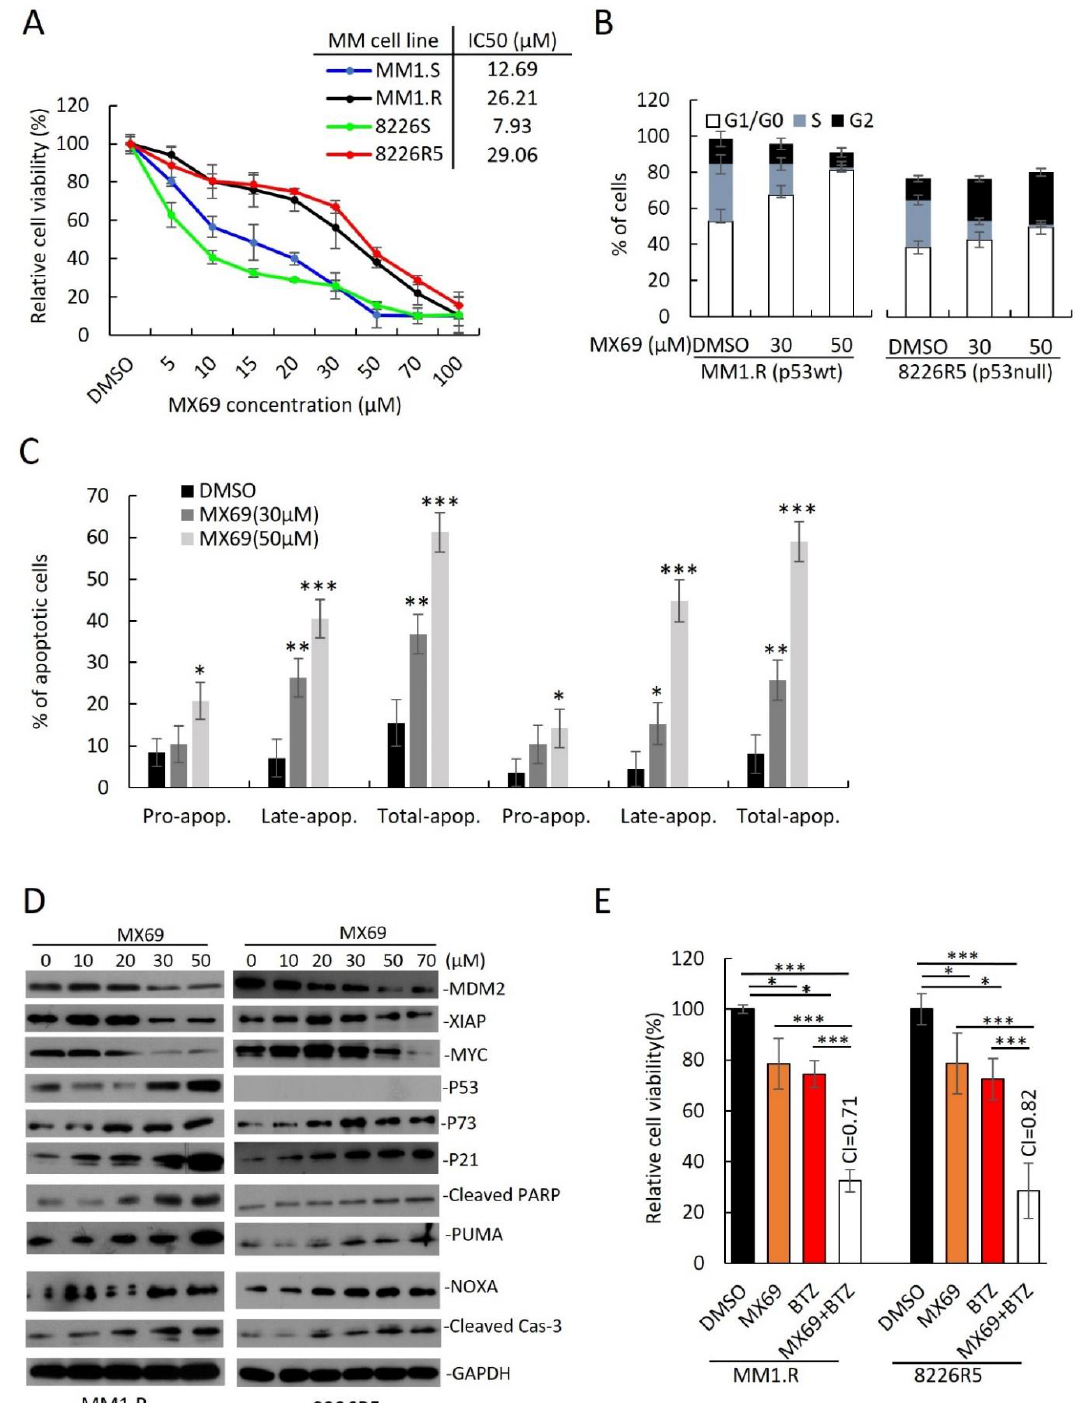
Figure 3. MX69 inhibits MM cell growth, apoptosis and cell cycle arrest in drug-resistant MM cells ( A ) Cell viability of MM cell lines after 48 h treatment with DMSO or different concentrations of MX69, as indicated. Figure insert — IC50 of MX69 in different MM cell lines, as indicated. Results are presented as mean ± SD of three independent experiments. ( B ) Bar plots indicate the distribution of cells in each cell cycle phase for MM1.R (p53wt) and 8226R5 (p53null) after 48 h treatment with DMSO or different concentrations of MX69, as indicated. Results are presented as mean ± SD of three independent experiments. ( C ) Apoptosis assay using flow cytometry after staining with an-